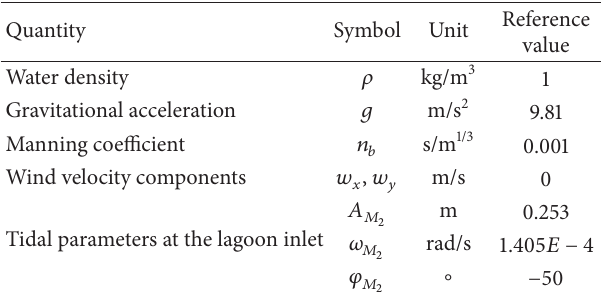
Table 1: Parameters and reference quantities considered in the present